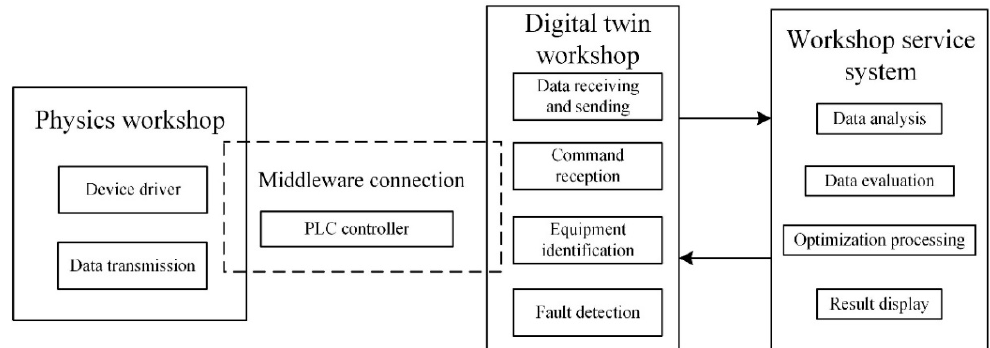
Figure 24. Twin system data communication mechanisms.